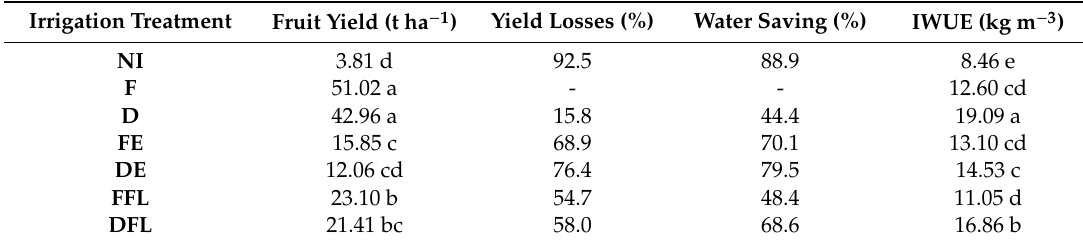
Table 4. Effects of irrigation treatments on some yield parameters in processing tomatoes cv. Hypeel F1. Values followed by the same letter do not statistically differ at p ≤ 0.05 (Tukey’s test). IWUE: irrigation water use efficiency.